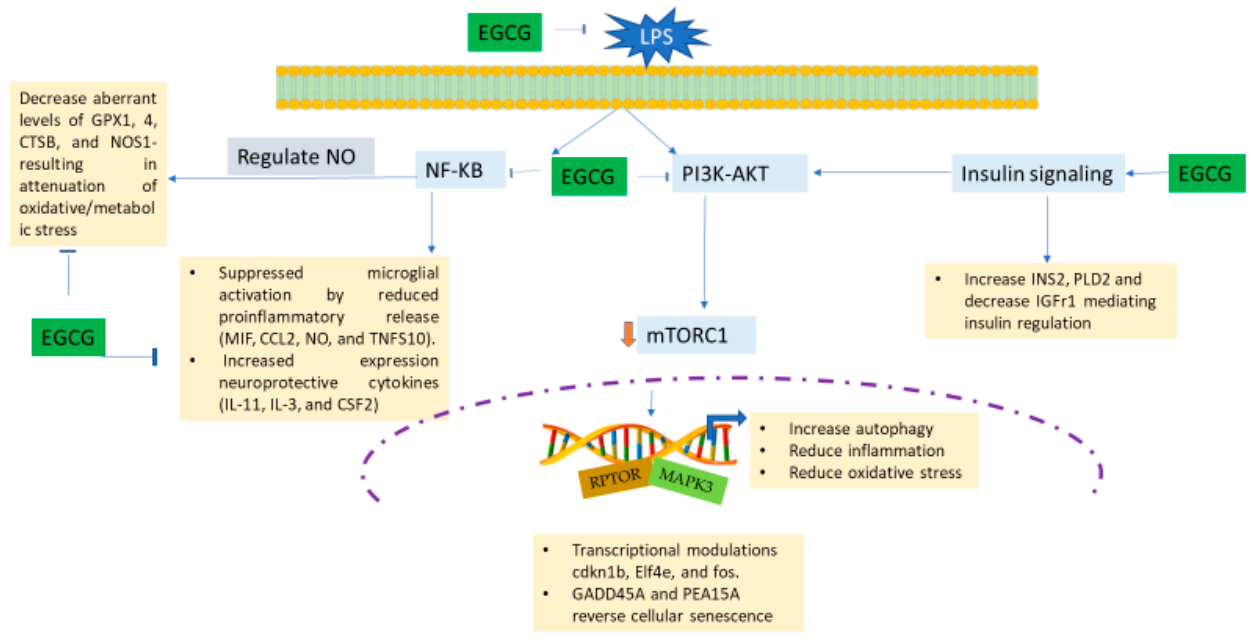
Figure 18. Schematic diagram showing a possible mechanism of EGCG inhibition of LPS-induced inflammatory and oxidative stress response leading to depression of neuroinflammation. Exper- imentation showed that EGCG diminished LPS-activated BV-2 microglial cells via the following suggested mechanisms: EGCG halted the NF- κ B and the PI3K-AKT pathway, which downregulates mTORC1, thus causing an increase in its anti-inflammatory and neuroprotective attributes. EGCG also controls insulin signaling to mediate PI3k-AKT. EGCG directs the regulation of nitric oxide via NF- κ B signaling, which results in the reduction of oxidative stress/metabolic stress. Additionally, transcriptional modulators may be involved in further neuro-rescue and anti-senescent capabilities of